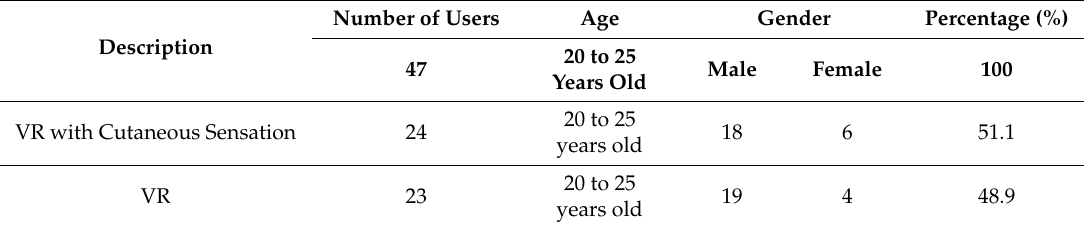
Table 2. User profile breakdown from the previous study [10]. Copyright © 2020, Springer-Verlag London Ltd.